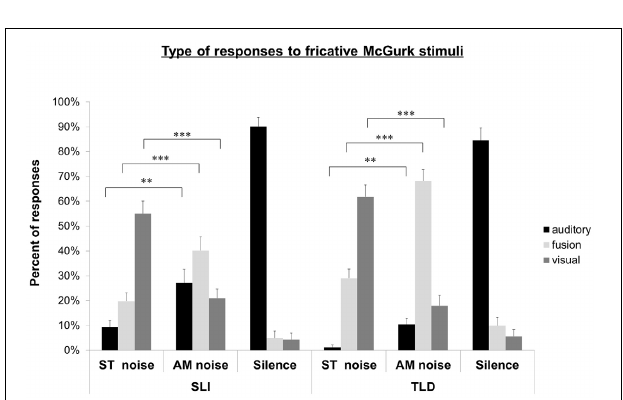
FIGURE 3 | Experiment 2. Auditory, fusion, and visual responses to McGurk fricative stimuli for SLI and TLD groups in ST noise, AM noise and quiet conditions. ∗∗ p < 0 . 01; ∗∗∗ p < 0 .